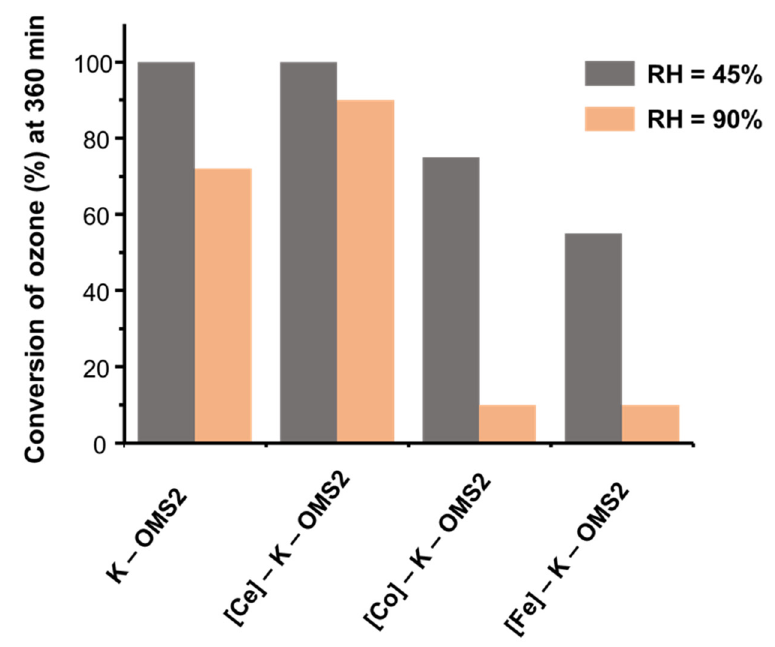
Figure 16. Conversion of ozone at 360 min with isomorphic Ce-, Co- and Fe-doped, and undoped (K–OMS–2) catalysts at different relative humidity (RH) values. Data extracted from [106].